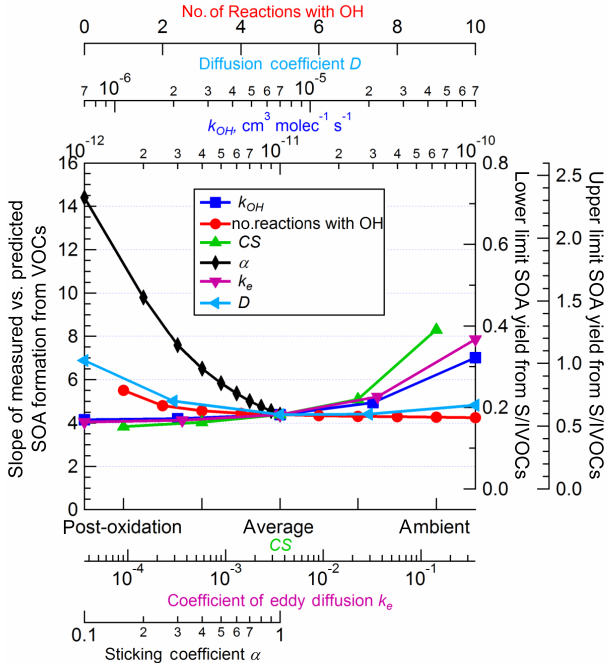
Figure 13. Sensitivity of the slope of measured vs. predicted SOA formation from VOCs, and of the range of SOA yields estimated for bulk S/IVOCs (same curves, different y axes), to parameters in the LVOC fate model. The change in slope and yields is calculated by changing only one parameter at a time while keeping the rest at the following base case values: five reactions with OH, k OH = 1 × 10 − 11 cm 3 molec − 1 s − 1 , average of CS measured in ambient air and after OFR oxidation, α = 1, k e = 0 . 0036s − 1 , and D = 7 × 10 − 6 m 2 s − 1